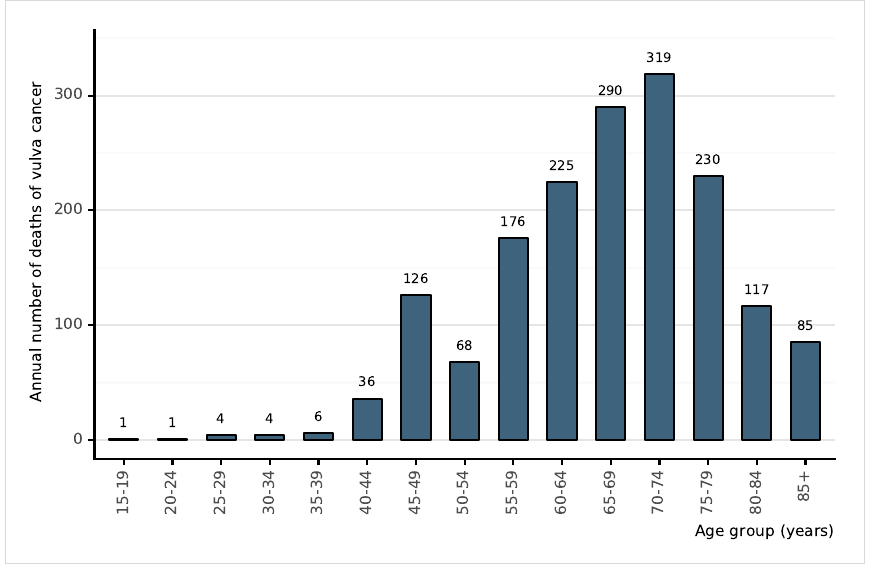
Figure 24: Annual number of deaths of vulva cancer in India (estimates for